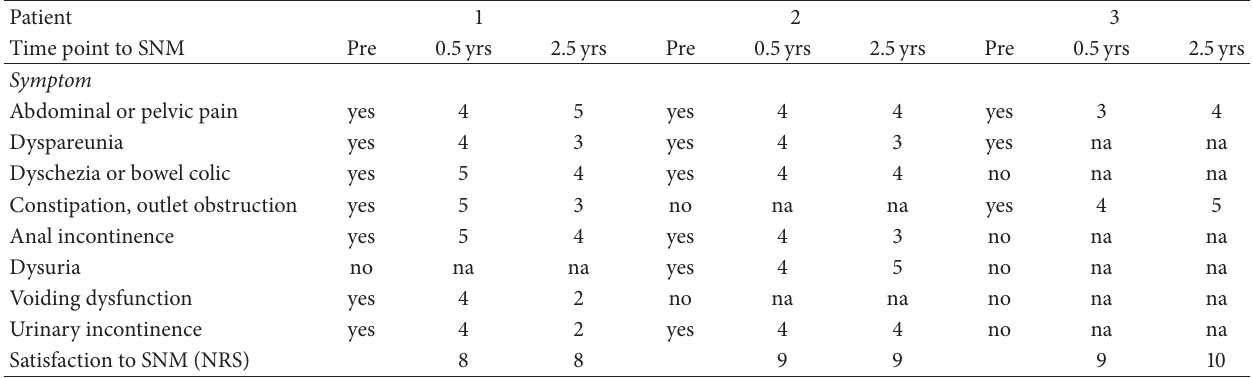
Table 2: Main pre-SNM symptoms and response to SNM